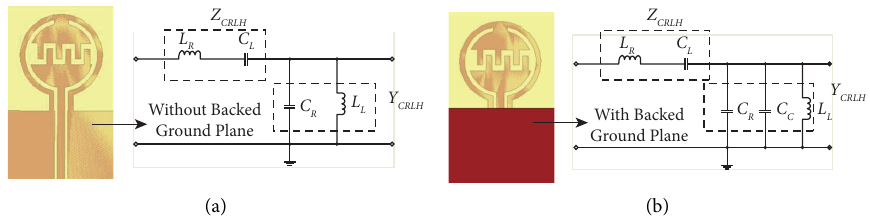
Figure 1: Equivalent circuit diagram (a) without backed ground plane, and (b) with backed ground plane of the proposed dual-band MTM